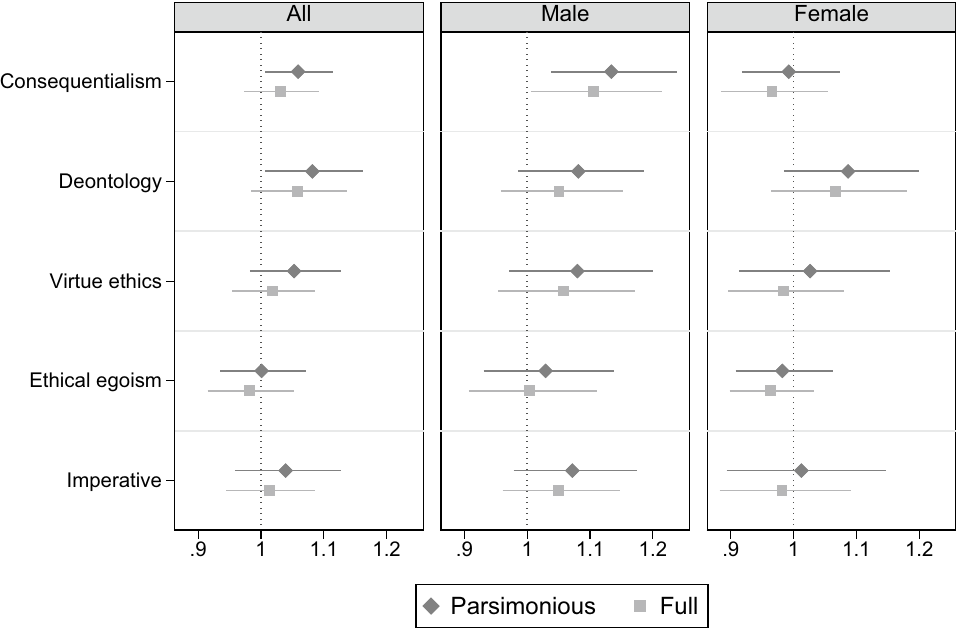
Figure 2. Relationship between moral messages and donation rates, pooled and by